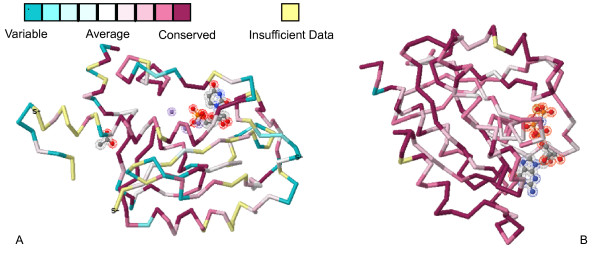
Three-dimensional conservation grading of ISG20 (A) and RAB30 (B). Two 3-D backbone structures of ISG20 and RAB30 were retrieved from PDB code 1WLJ and 2EW1, respectively. (A) The putative conservation grading was based on the alignment of twenty mammalian protein sequences from: Human (Homo sapiens), Chimpanzee (Pan troglodytes), Orangutan (Pongo pygmaeus), Gorilla (Gorilla gorilla), Macaque (Macaca mulatta), Cow (Bos taurus), Dog (Canis familiaris), Horse (Equus caballus), Cat (Felis catus), Guinea Pig (Cavia porcellus), Mouse (Mus musculus), Rat (Rattus norvegicus), Megabat (Pteropus vampyrus), Microbat (Myotis lucifugus), Pika (Ochotona princeps), Hyrax (Procavia capensis), Tree Shrew (Tupaia belangeri), Dolphin (Tursiops truncatus), Opossum (Monodelphis domestica), Platypus (Ornithorhynchus anatinus). (B) These conservation grades were based on the aligned twenty-two mammalian protein sequences from Human (Homo sapiens), Cow (Bos taurus), Dog (Canis familiaris), Guinea Pig (Cavia porcellus), Horse (Equus caballus), Cat (Felis catus), Elephant (Loxodonta africana), Macaque (Macaca mulatta), Mouse Lemur (Microcebus murinus), Opossum (Monodelphis domestica), Mouse (Mus musculus), Microbat (Myotis lucifugus), Pika (Ochotona princeps), Platypus (Ornithorhynchus anatinus), Rabbit (Oryctolagus cuniculus), Chimpanzee (Pan troglodytes), Orangutan (Pongo pygmaeus), Hyrax (Procavia capensis), Megabat (Pteropus vampyrus), Rat (Rattus norvegicus), Tree shrew (Tupaia belangeri), Dolphin (Tursiops truncatus). The color bars from the left to the right measure changes from variable to conserved residues. Conservation grading in yellow indicates the residues whose conservation degrees were not supported with sufficient data.